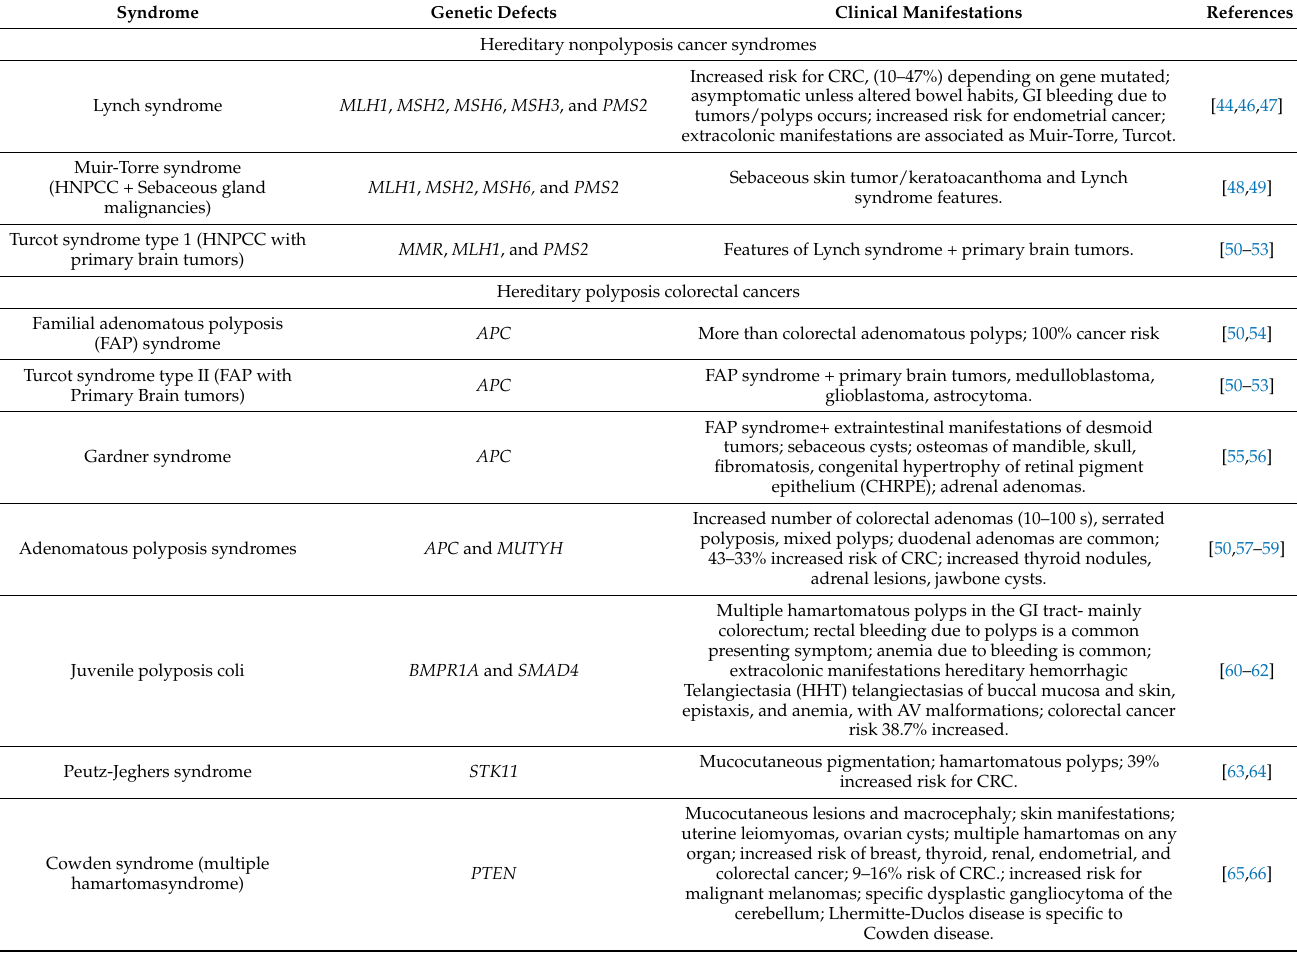
Table 1. Genes involved in different CRC syndromes and associated clinical